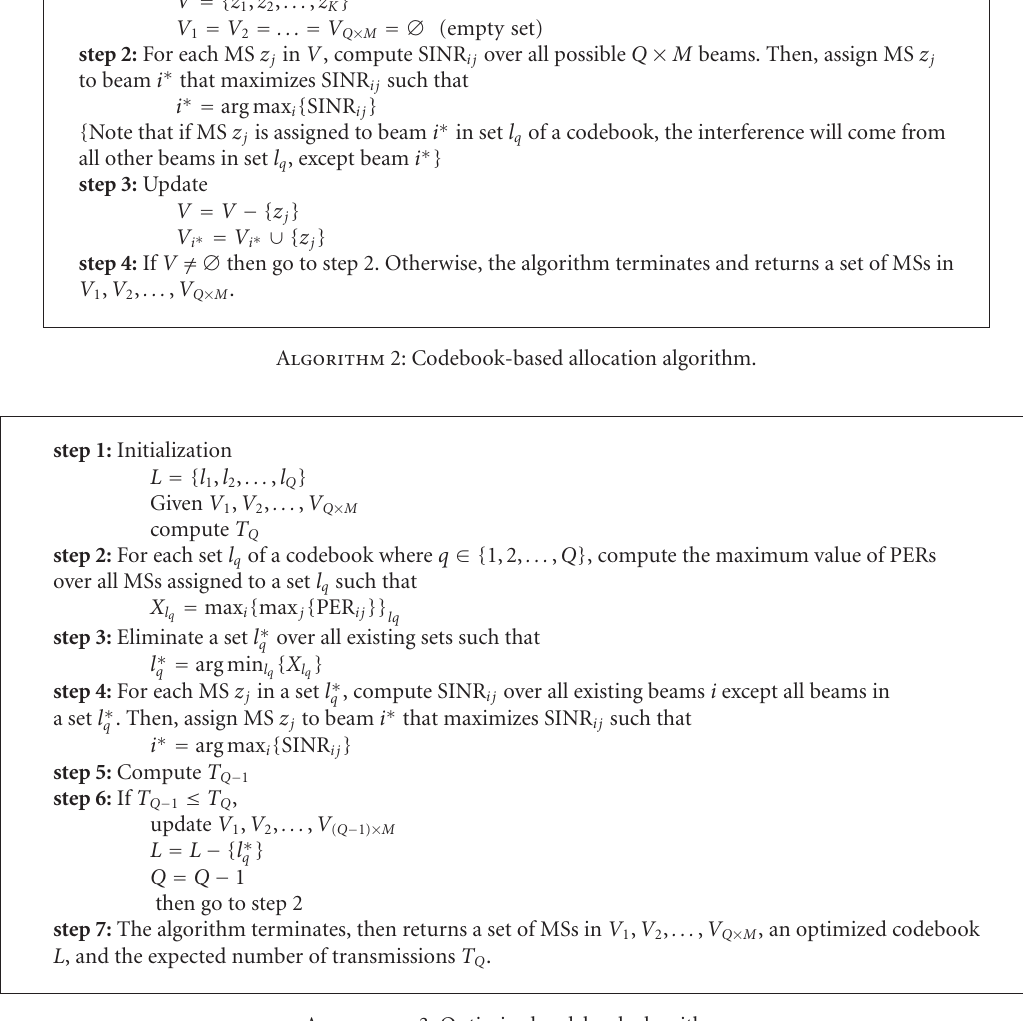
Algorithm 3: Optimized codebook